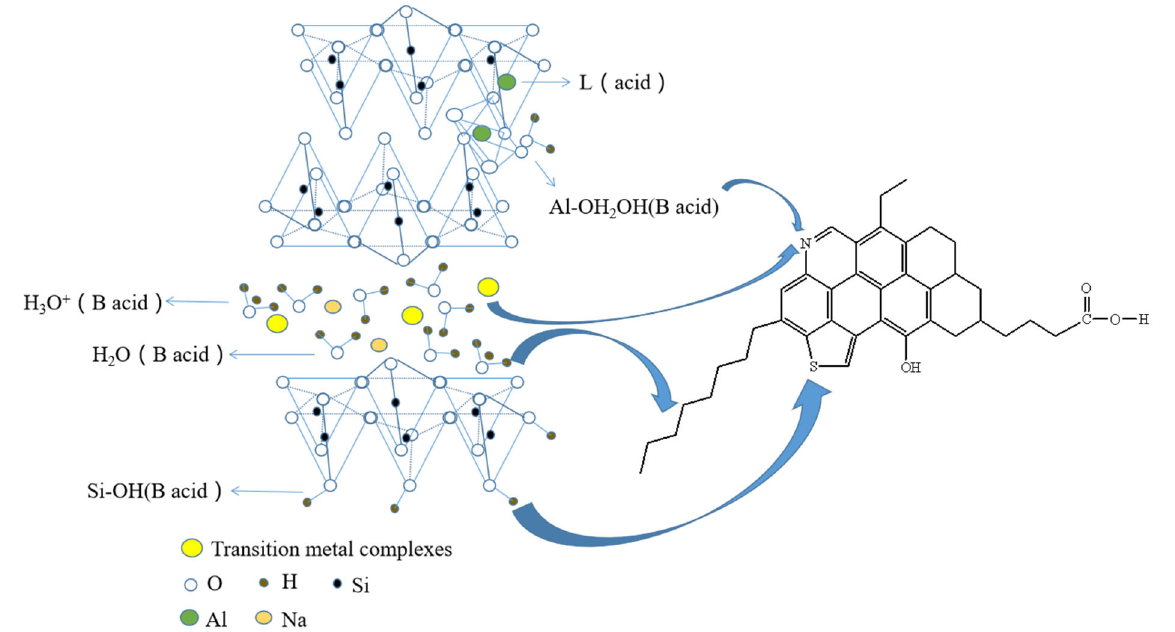
Figure 19. Catalytic mechanism of bentonite and transition metal complexes.